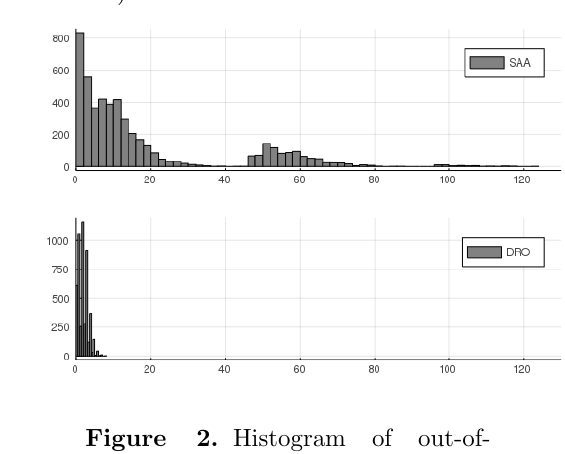
Figure 1. Histogram of out-of- sample performance( π c = 0 . 9 , π ab = 0 . 9)